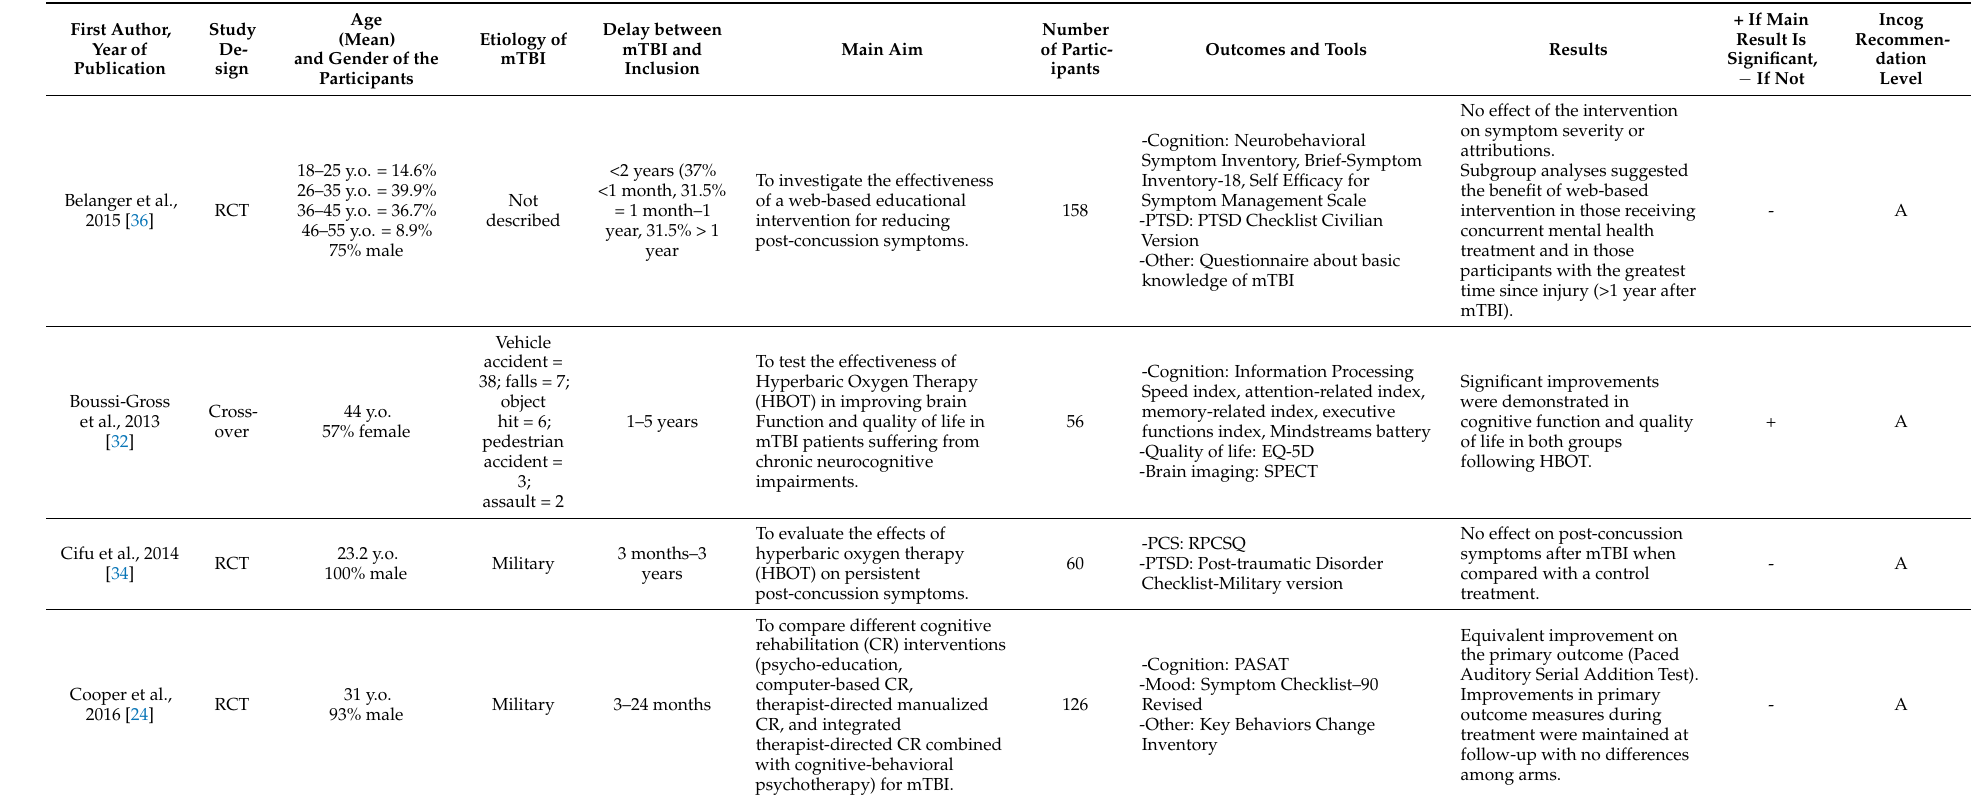
Table A1. Cognition and PCS (18